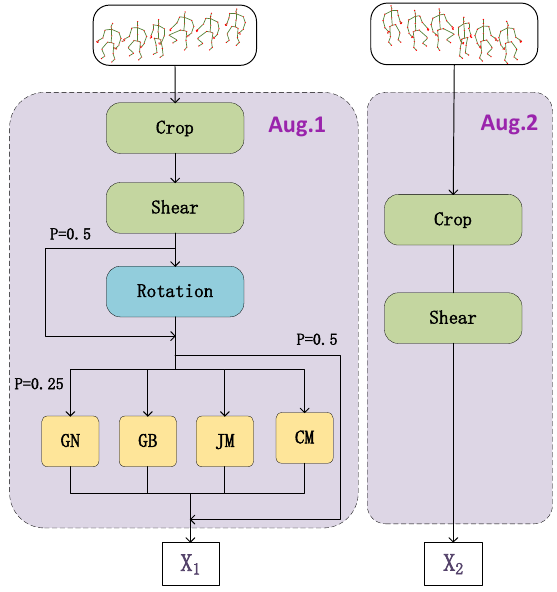
Figure 1. Asymmetric data augmentation pipeline.